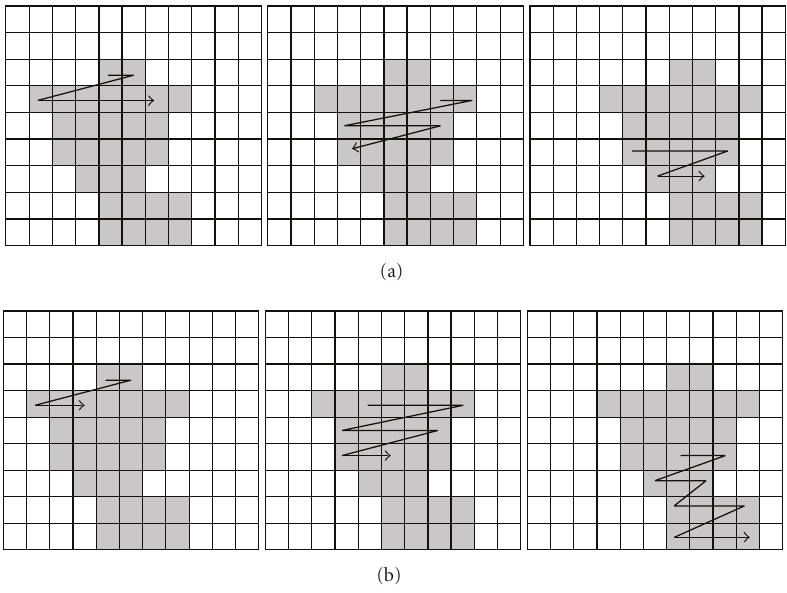
Figure 2: Intra-refresh of motion-active macroblocks: (a) operation of the standard AIR algorithm with a fixed number of macroblocks per frame; (b) operation of the SC-AIR algorithm with a variable intra-refresh